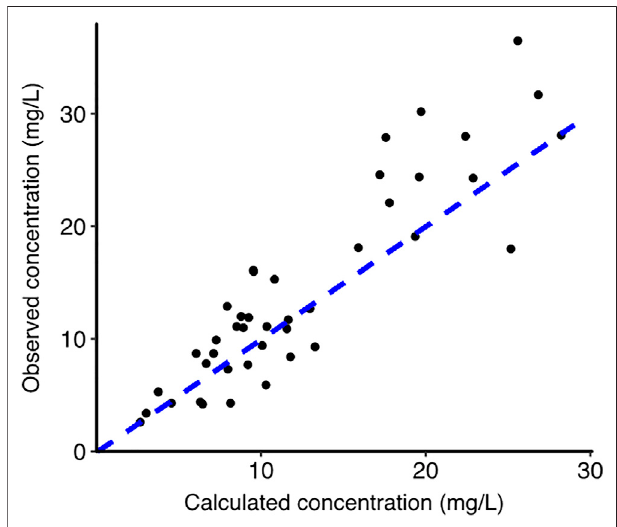
FIGURE 4 | Scatter plot for tranexamic acid concentration in mg/L measured in plasma versus the calculated plasma concentration estimated from VAMS capillary blood samples ( n (cid:1) 42). The blue dotted line represents the line of identity ( y (cid:1) x